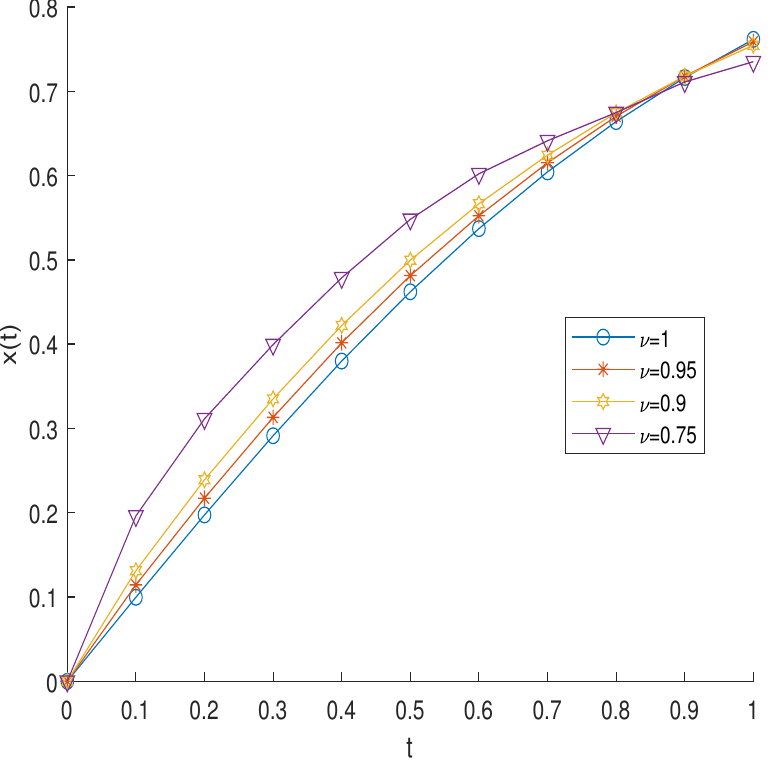
Figure 5. MLG solutions of x ( t ) for N = 10 with ν = { 0.75,0.9,0.95,1 } and Example 3. Figure 6 for N = 12 , the absolute error for Example 3